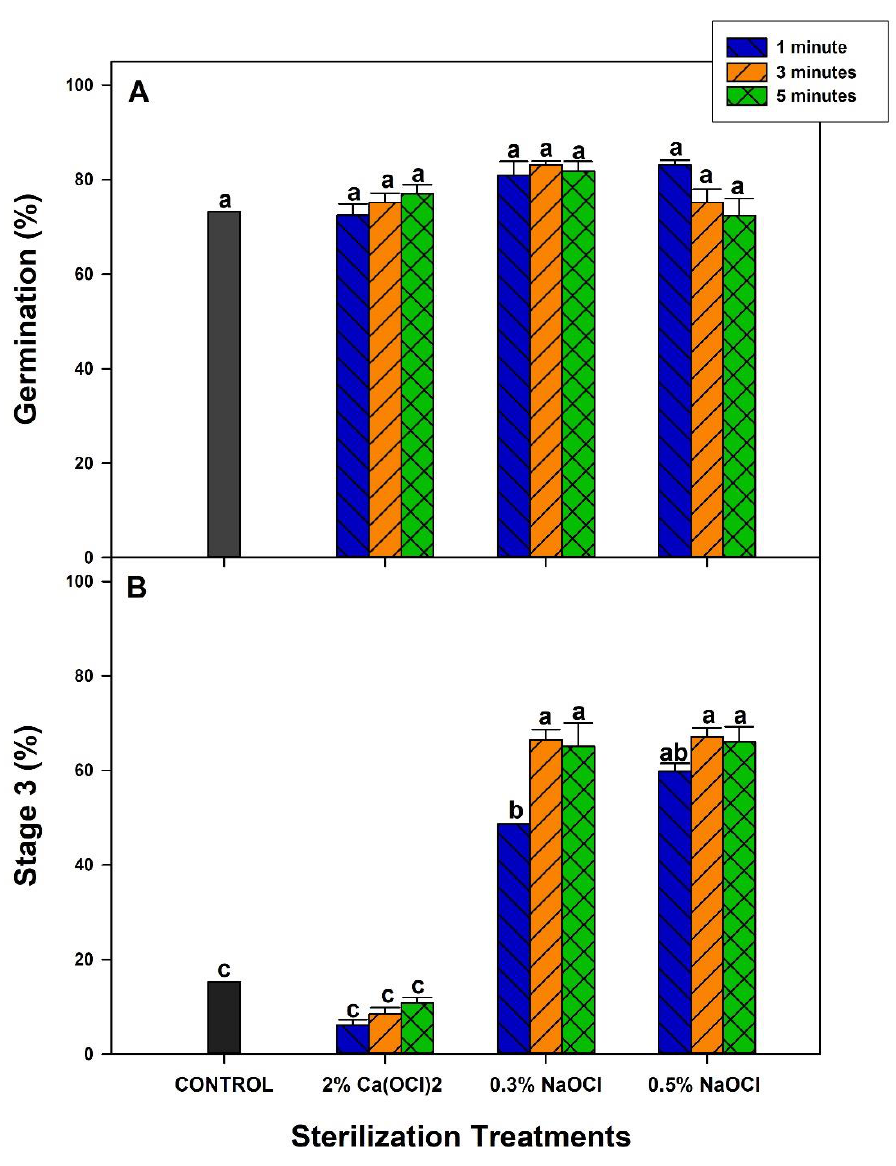
Figure 4. Effects of seed surface sterilization treatments on seed germination ( A ) and protocorm formation ( B ) of Epidendrum geminiflorum cultured on P723 under 24 h-dark/0 h-light at 20 °C for 2 wks. Histobars with the same letter are not significantly different ( α = 0.05).